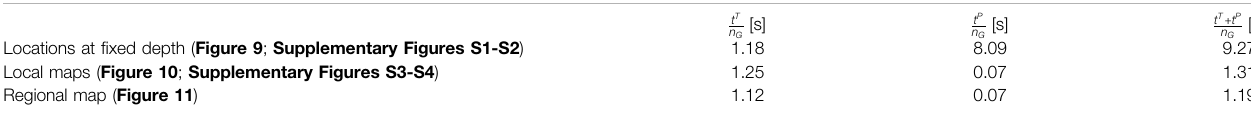
TABLE 3 | Computational times in seconds per output location for emulation construction and prediction using MOGP on a Xeon E5-2620V3 2.4 GHz × 12 workstation.